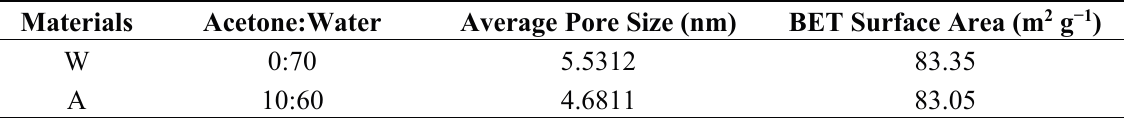
Figure 3. Nitrogen gas adsorption-desorption isotherms and BJH pore size distribution (inset) of ( a ) W; ( b ) A; ( c ) WW; ( d ) AA. Table 2. Average pore size and BET surface area of SnO 2